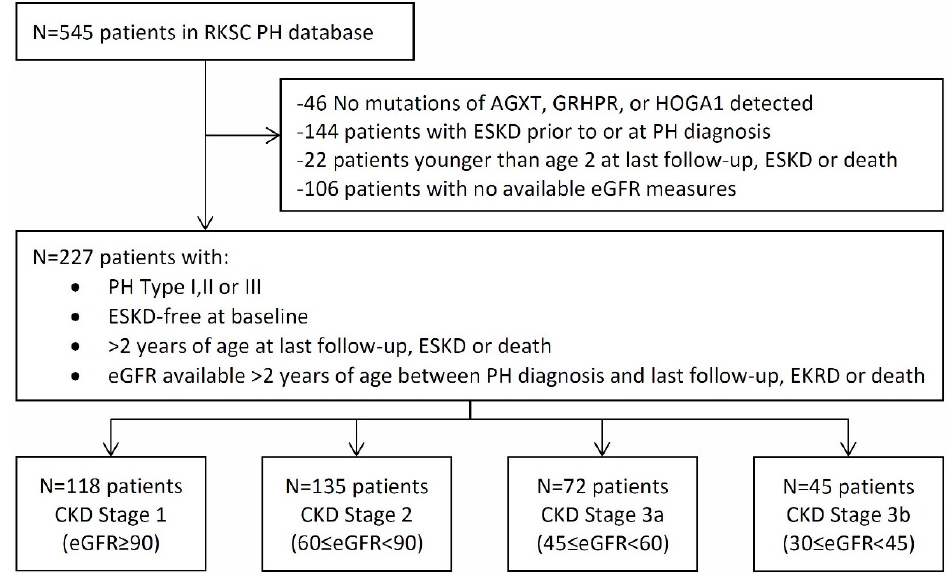
Figure 1. Flowchart of inclusion criteria for analysis cohort. From a total of 545 PH1 patients in the Registry, 227 were eligible for this analysis.